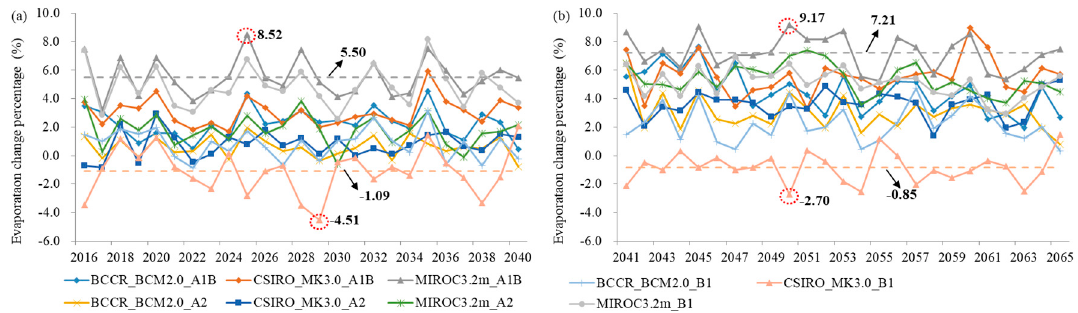
Figure 11. The forecasted evaporation change percentage relative to 1980–2004 period under CMIP3: